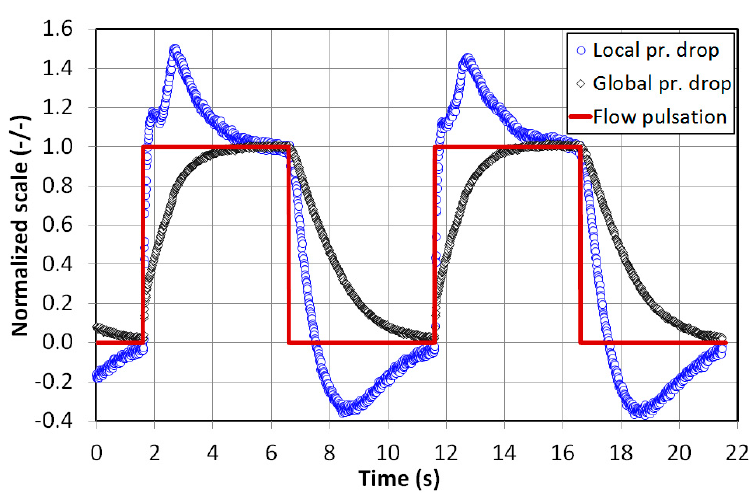
Figure 2. Response of the pulsed fluidized bed subjected to a flow pulsation of 0.1 Hz .